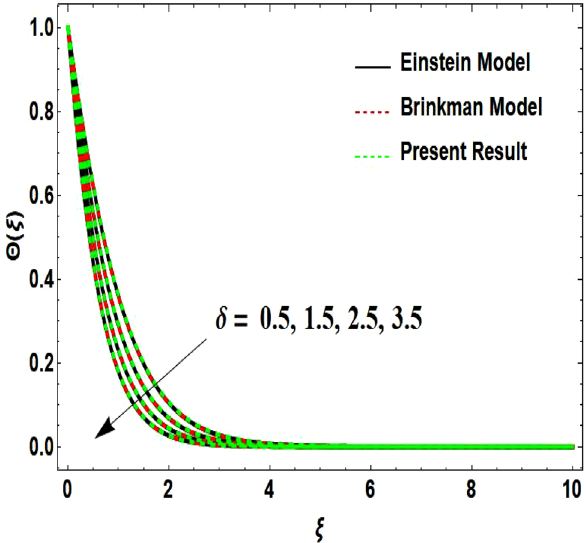
Figure 7. Temperature curve influenced by surface wall thickness parameter.